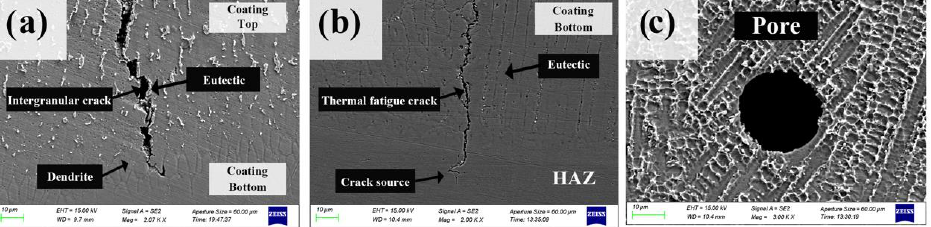
Figure 9. Different types of defects in IN718 coating: ( a ) intergranular crack in Sample 1600-10; ( b ) thermal fatigue crack in HAZ of Sample 1600-15; ( c ) pore in Sample 1600-15.